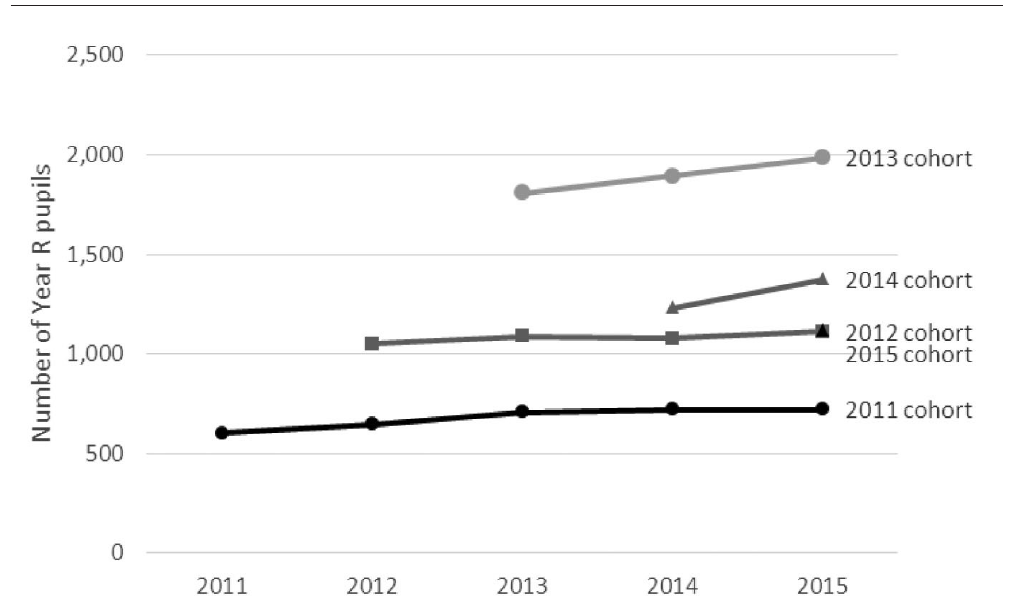
Figure 3: Pupil roll at free schools by year of opening (primary schools)